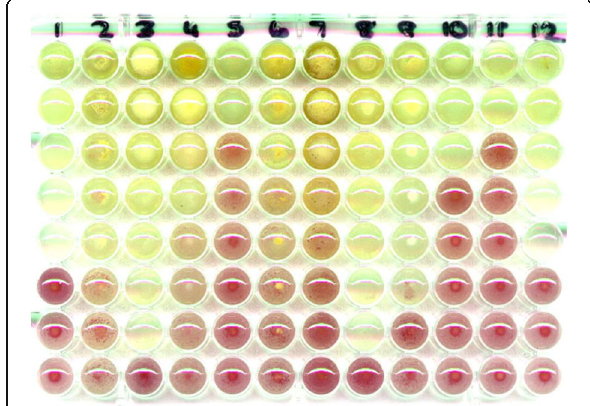
Fig. 2 Microplate of serially diluted acetone extracts of 12 Combretum species treated with INT and incubated overnight. Microbial growth of Staphylococcus aureus indicated by red colour. If started with 10 mg/ml extract the MIC of lane 11 was 1.25 mg/ml and of lane 8 was 0.04